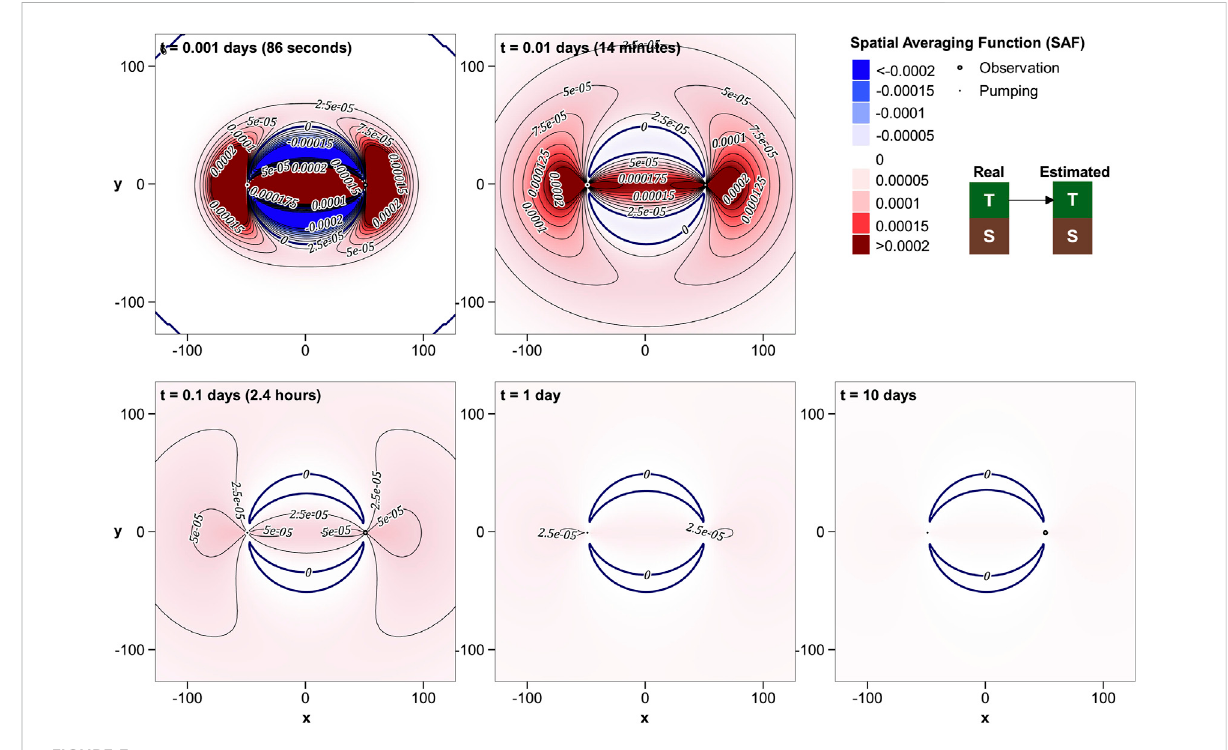
FIGURE 3 R ′ T − T for separated wells at fi ve different